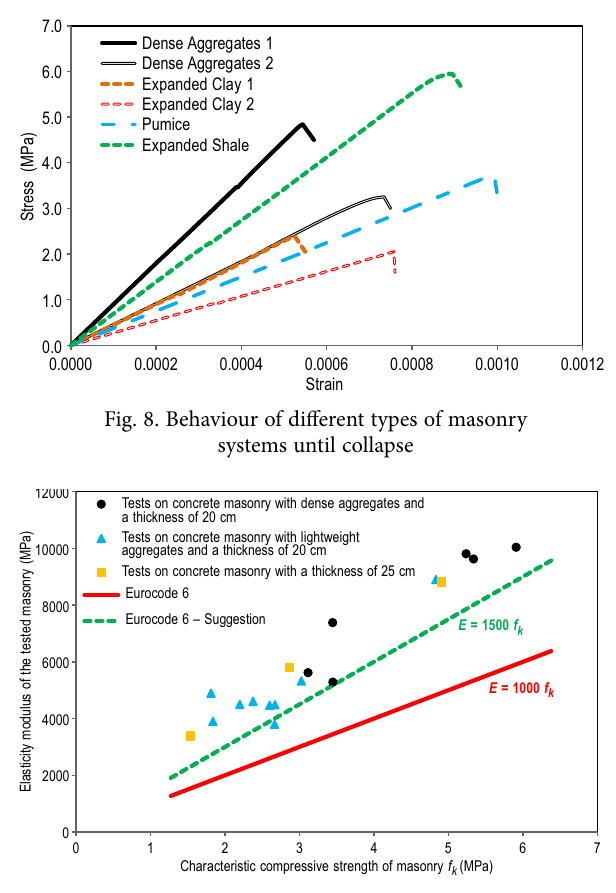
Fig. 9. Elasticity modulus for the tested masonry and comparison with Eurocode 6